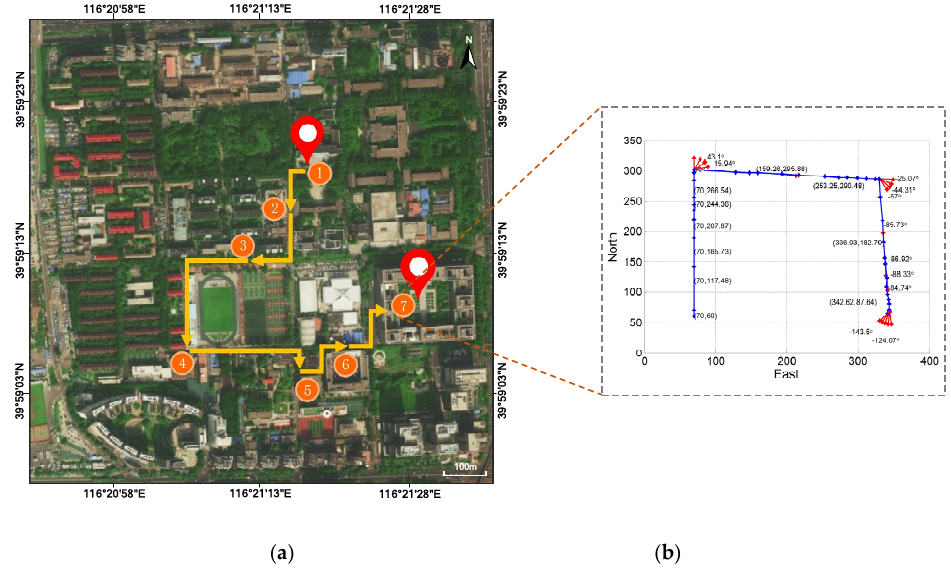
Figure 17. The FPV ‐ based pedestrian navigation result on the expanded BuaaFPV dataset. ( a ) plots the scene recognition result with a route estimation; ( b ) shows the movement estimation and tracking result. Orange circles represent the identified scene position and sort by time, while yellow arrows represent estimated routes.